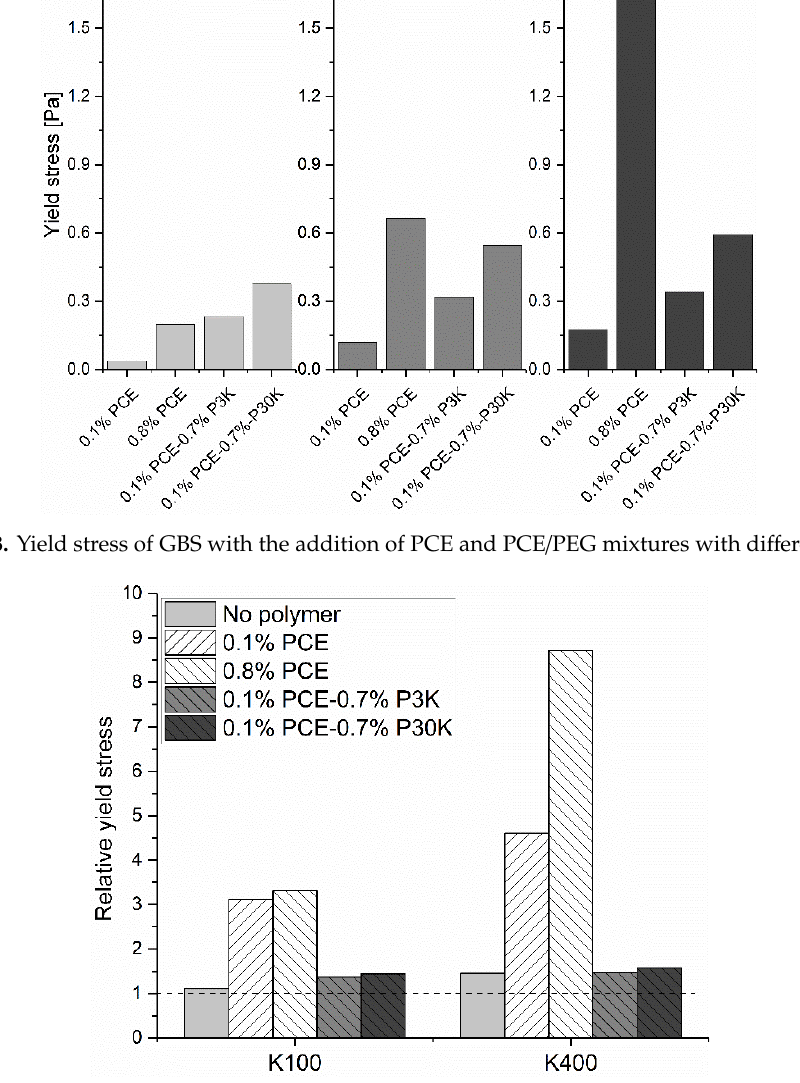
Figure 8. Yield stress of GBS with the addition of PCE and PCE/PEG mixtures with different [K + ].